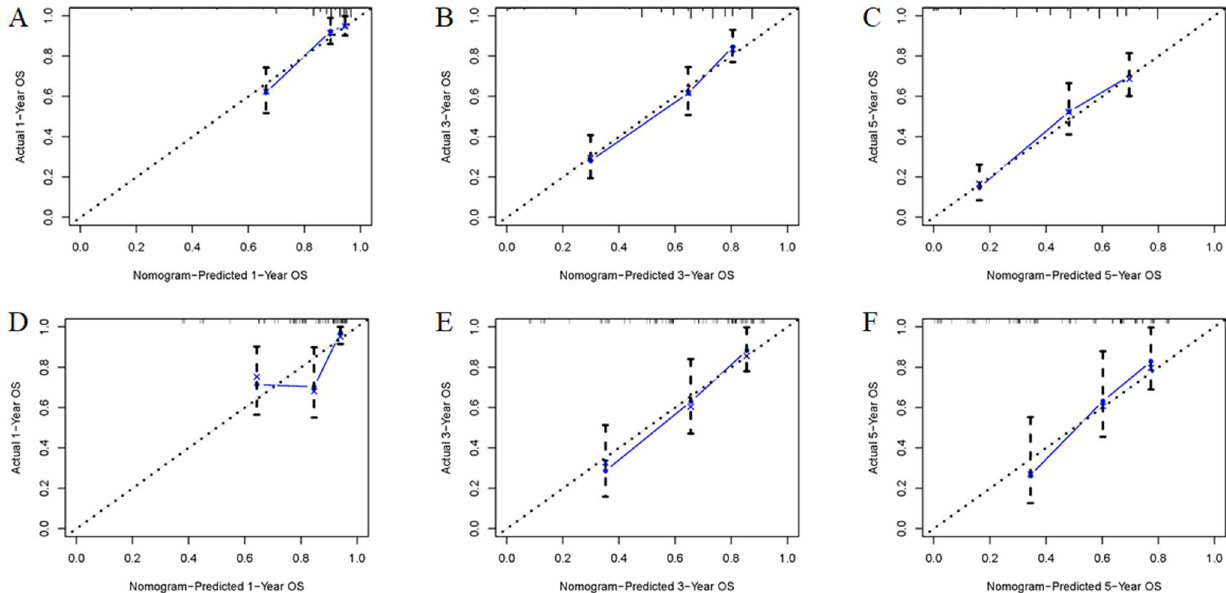
Figure 3. Calibration curves of the nomogram for predicting 1, 3, and 5 years OS in the training set ( A – C ) and 1, 3, and 5 years OS in the validation set ( D – F ). Figure was generated by R software version 4.03 (http:// www.r- proje ct.